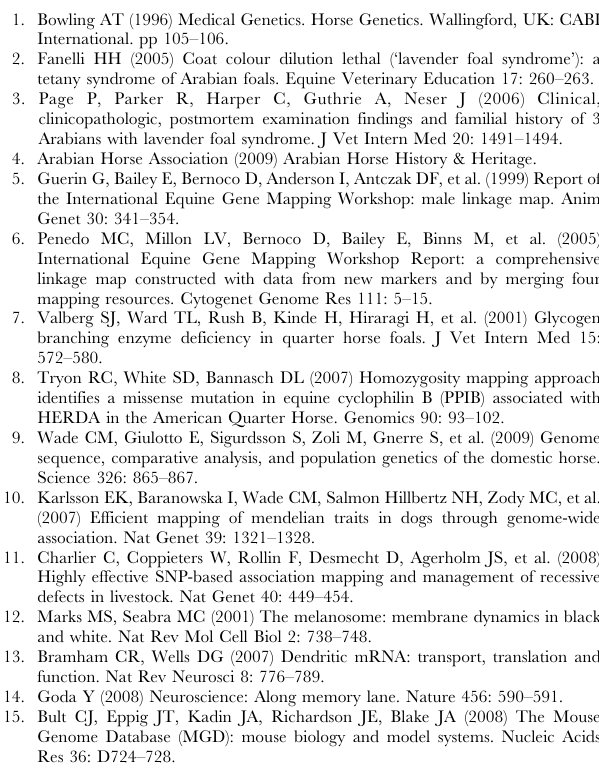
Figure S1 Pedigree of horses used in this study. Red indicates affected, blue indicates carriers, and green highlights horses chosen for genotyping. Figure S2 Average genome-wide LD in four horse breeds. The Egyptian (sub-group of the Arabian) and the Thoroughbred, both with a long history of a closed stud book, have relatively long LD in contrast to the Arabian and Saddlebred breeds. Figure S3 Multiple alignment of MYO5A exon 30 amino acid sequences from eight diverse species and an LFS horse demonstrating the high level of conservation in this region of the gene. The first amino acid changed by the g.138235715del is marked with a yellow arrow. A star denotes completely conserved amino acids.